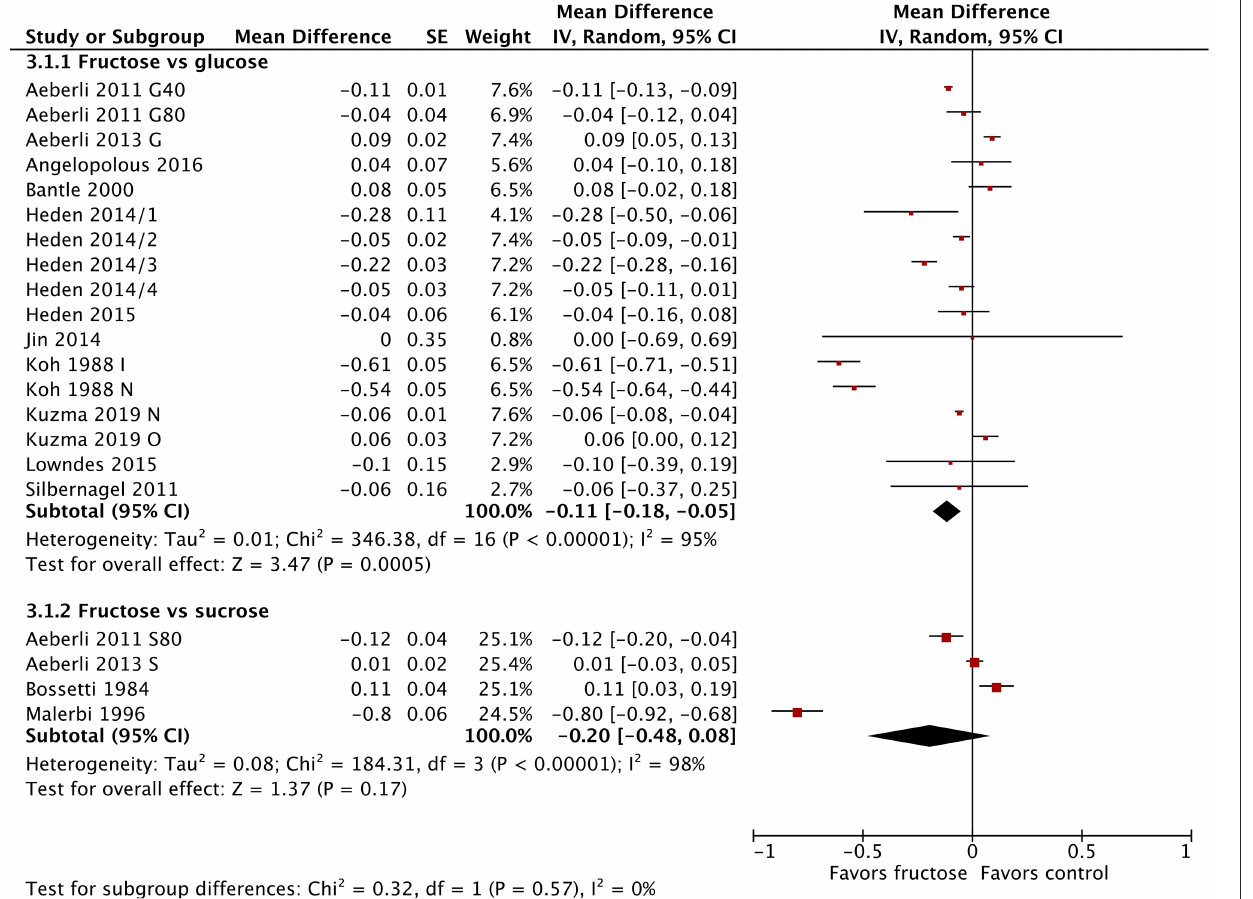
( Supplementary Figures 10–12 ). Baseline BMI did not influence blood insulin